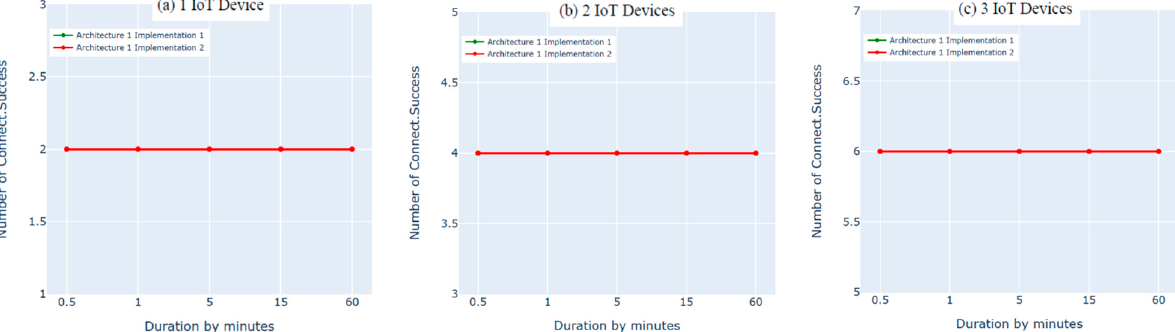
Figure 12. AWS IoT message broker Connect.Success metric with 1, 2, and 3 IoT devices on North Virginia datacenter (cloud layer).